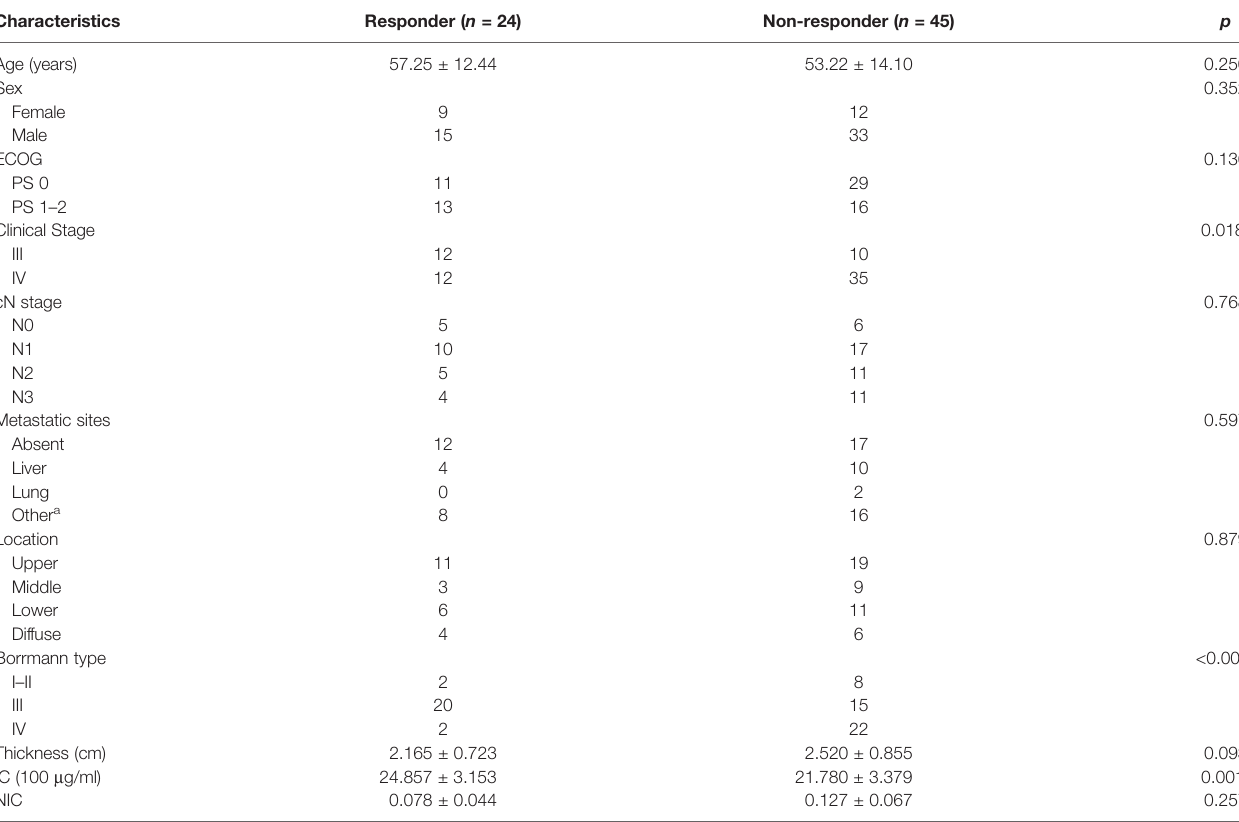
TABLE 1 | Baseline characteristics of responder and non-responder groups.